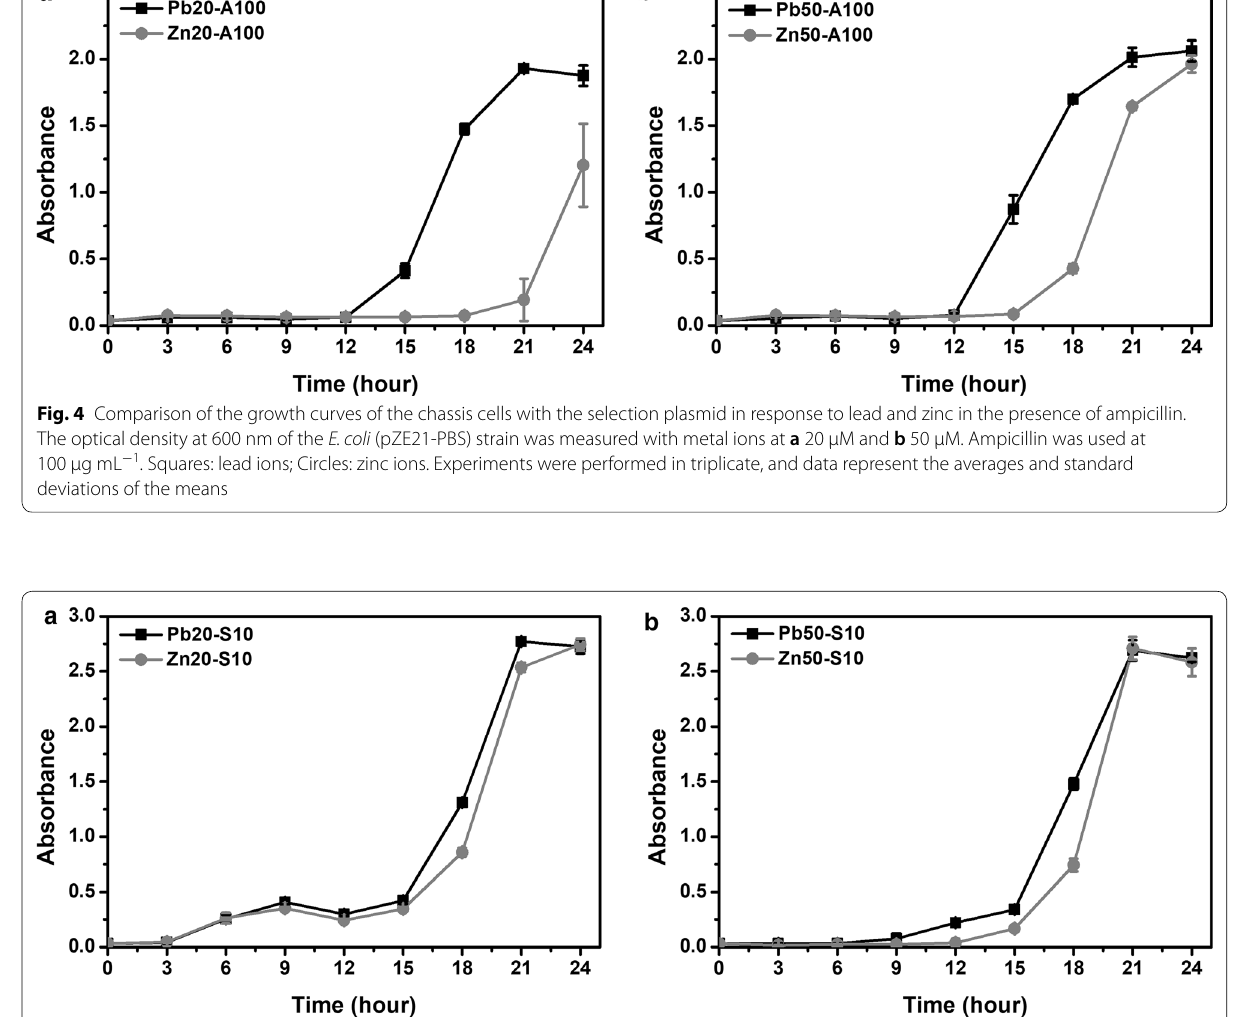
Fig. 5 Comparison of the trowth curves of the chassis cells with the selection plasmid in response to lead and zinc in the presence of sucrose. The optical density at 600 nm of the E. coli (pZE21-PBS) strain was measured with metal ions at a 20 µM and b 50 µM. Sucrose was used at 10 g L − 1 . Squares: lead ions; Circles: zinc ions. Experiments were performed in triplicate, and data represent the averages and standard deviations of the